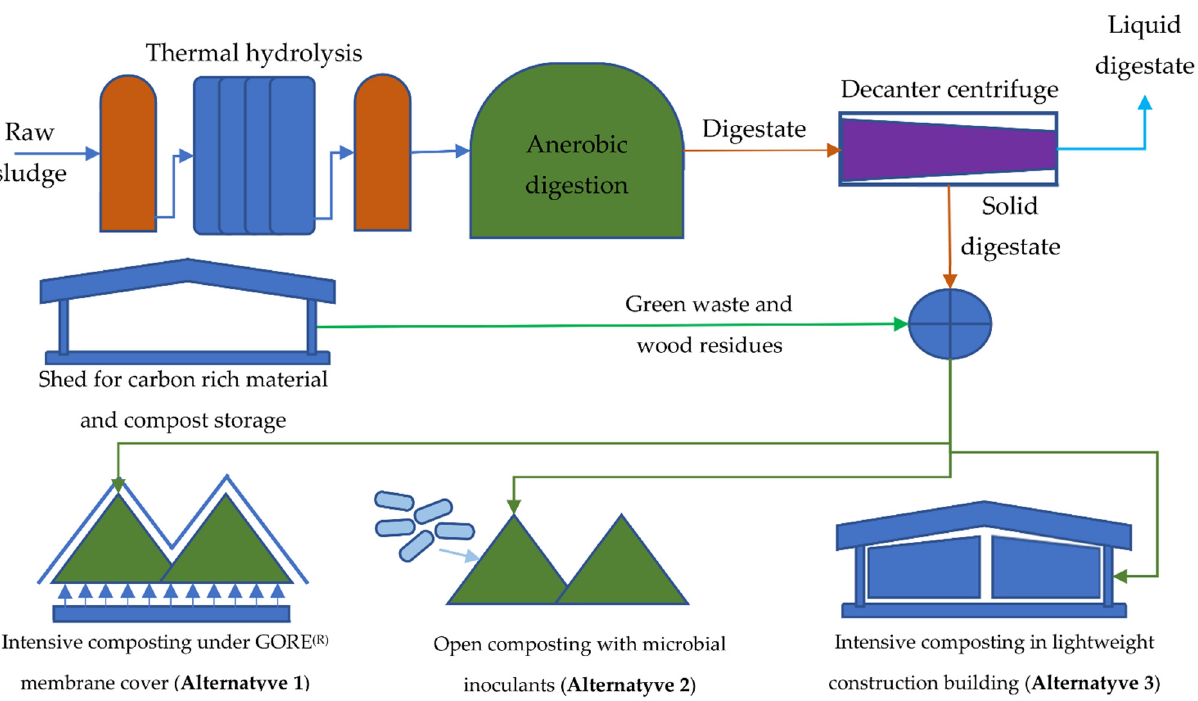
Figure 2. Visual representation of alternatives under consideration.